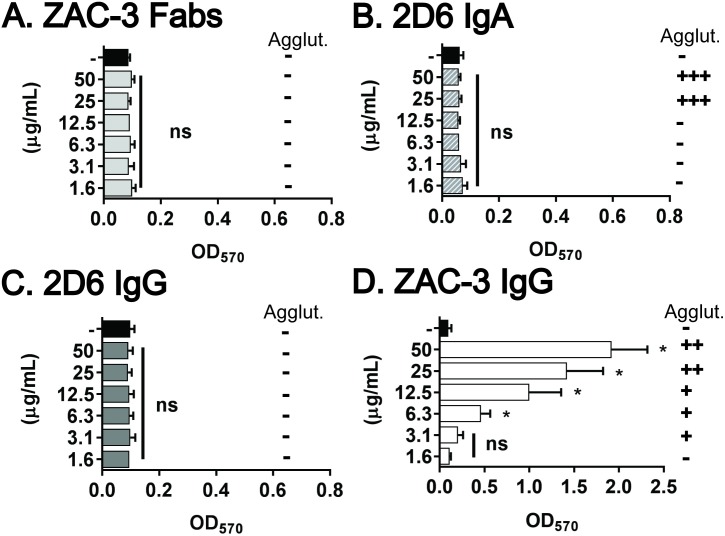
Relationship between agglutination and ECM production by V. cholerae O395.CV staining induced following treatment (2.5 h) with (A) ZAC-3 Fab fragments, (B) 2D6 IgA, (C) 2D6 IgG and (D) ZAC-3 IgG at the indicated concentrations (y-axis). Note that panel (D) is reproduced from Fig 2A for the sake of comparison. Appropriate isotype and Fab controls (50 μg/mL) were included in each experiment and are shown by solid black bars. Vertical symbols indicate macroagglutination (Agglut.);—no agglutination; +++ agglutination within 1 h; ++ agglutination within 2 h, and + agglutination within 3 h. Each graph constitutes at least three biological replicates with three technical replicates each. Statistical significance across treatments was determined by one way ANOVA, followed by a Tukey multiple comparison test, *; P< 0.05. ns; not significant.